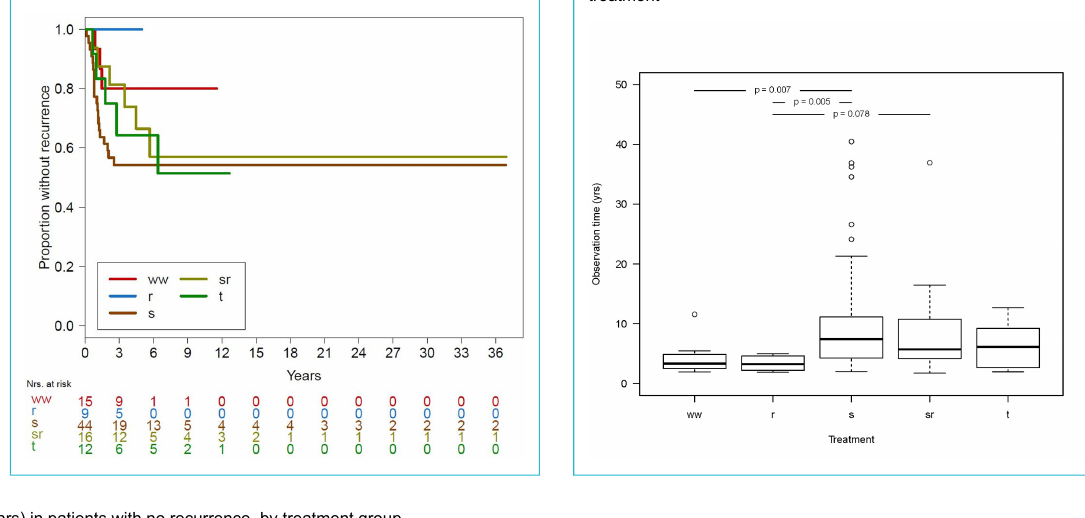
Figure 2: Boxplot shows that the observation time was shorter in the radiation treatment group compared to the surgery and surgery with radiation groups (marginally significant differences). The ob- servation time in the watchful waiting group was shorter than in the surgery group.ww = watchful waiting; r = radiation alone; s = surgery alone; sr = surgery combined with radiation; t = systemic treatment